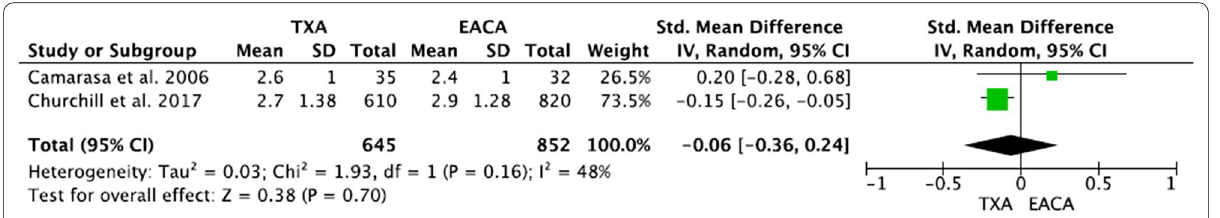
Fig. 4 Difference in pre- and post-operative Hb